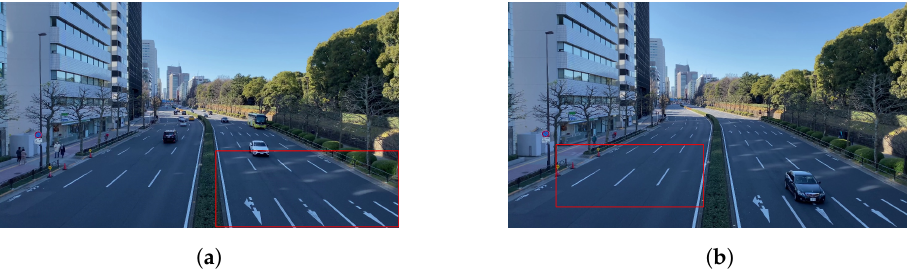
Figure 10. First frames of the Sample scenario #1. ( a ) Front view of the Sample scenario #1; ( b ) rear view of the Sample scenario #1. Source of the input video: [26].